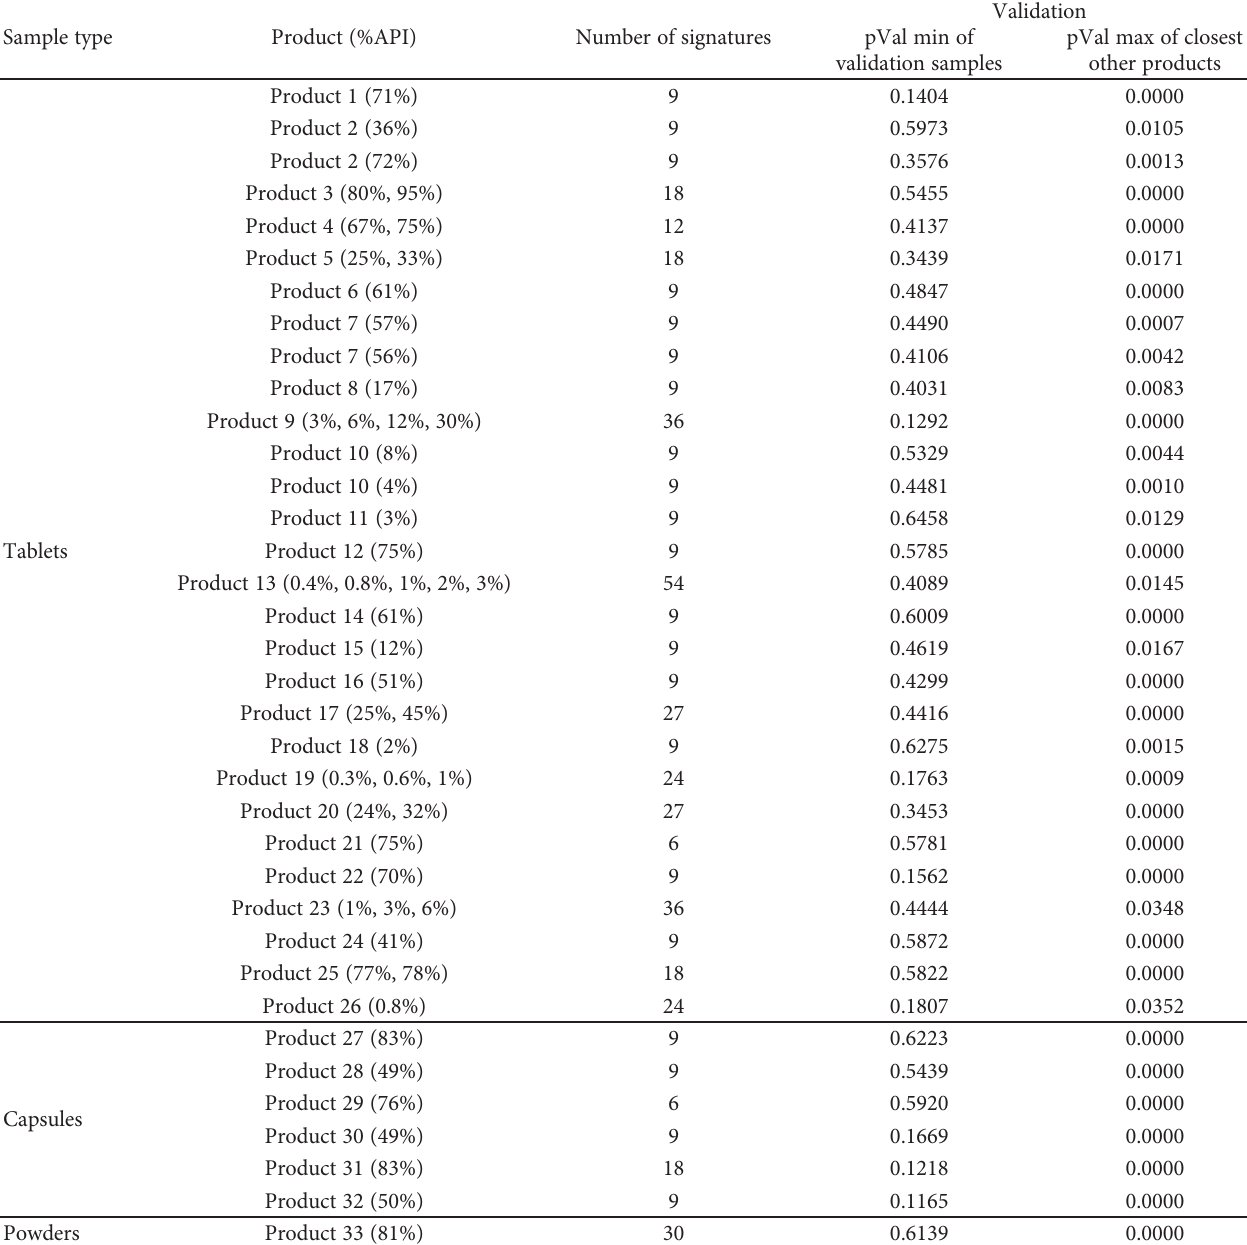
Table 1: Validation results obtained with the genuine products. The number of signatures measured for each product has been added. The minimum p values (pVal min) obtained for the validation samples of the corresponding method are presented in the table together with the corresponding maximum p values (pVal max) of the closest other products. The device provides a positive identi fi cation for p values superior or equal to